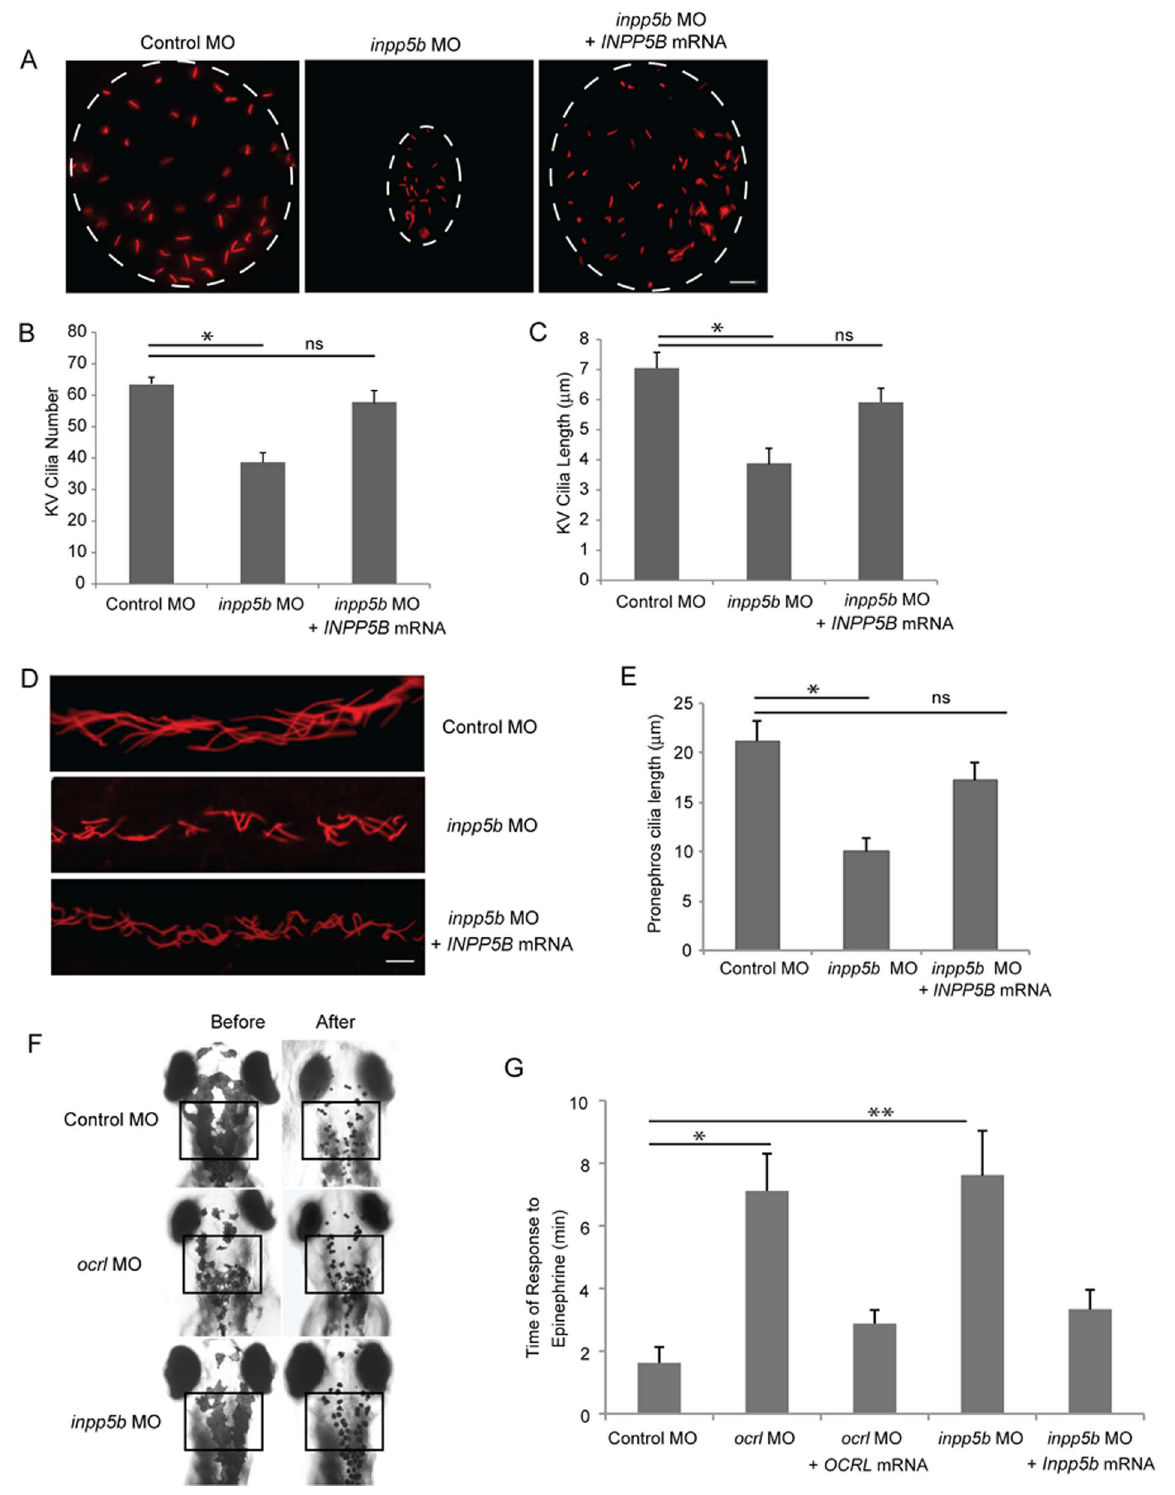
Figure 4. Defects of cilia formation in Inpp5b zebrafish morphants. (A) INPP5B WT mRNA rescue the loss of inpp5b . KV cilia of zebrafish embryos injected with control MO (4 ng), inpp5b MO (4 ng) or inpp5b MO (4 ng) and INPP5B WT mRNA (500 ng) at 6-somite stage were immunostained with acetylated a -tubulin (red), representative images are shown (dash line indicates border of KV). Scale bar 10 micron. (B–C) Quantification of number (B) and length (C) of KV cilia in zebrafish embryos injected with control MO (4 ng), inpp5b MO (4 ng) or inpp5b MO (4 ng) and INPP5B WT mRNA (500 ng). (N . 20 embryos, three independent experiments, unpaired t-test, * p=3.4E-03 in B and * p=1.9E-23 in C). (D) INPP5B WT mRNA rescue of inpp5b pronephric cilia formation. Representative image of pronephric cilia of zebrafish embryos at 24 hpf stage, injected with control MO (4 ng), inpp5b MO (4 ng) or inpp5b MO (4 ng) and INPP5B WT mRNA (500 ng), immunostaining with acetylated a -tubulin (red). Scale